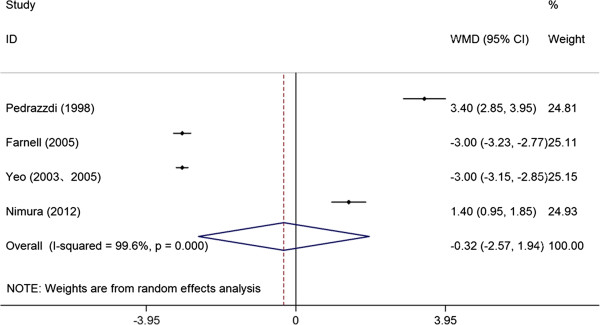
Forest plot for hospital stays between the pancreatoduodenectomy with extended lymphadenectomy (PD/ELND) group and the standard pancreatoduodenectomy (PD) group. The size of the black box corresponding to each study is proportional to the sample size, and the horizontal line shows the corresponding 95% CI of the relative risk (RR) displayed on the right.